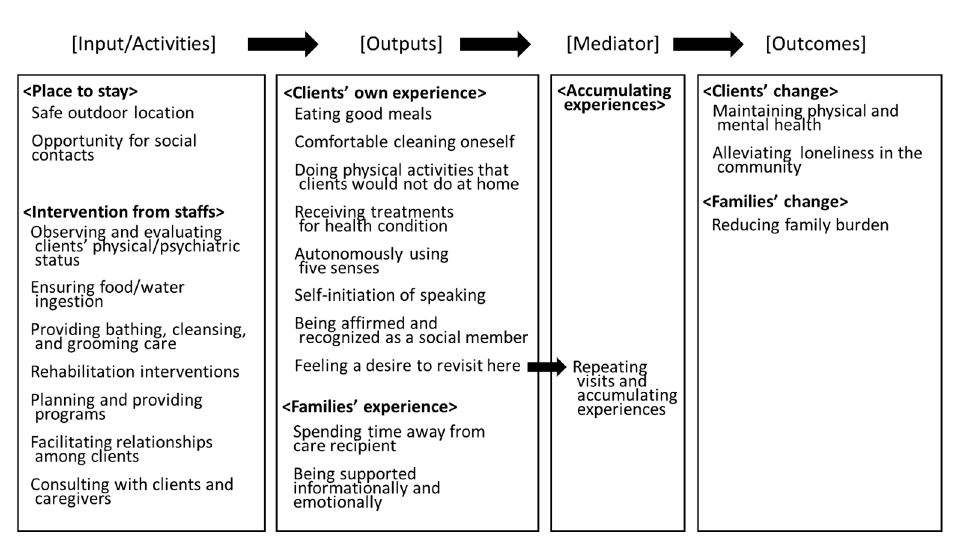
Figure A1. The logic model of Japanese clients’ adult day care service use [13].